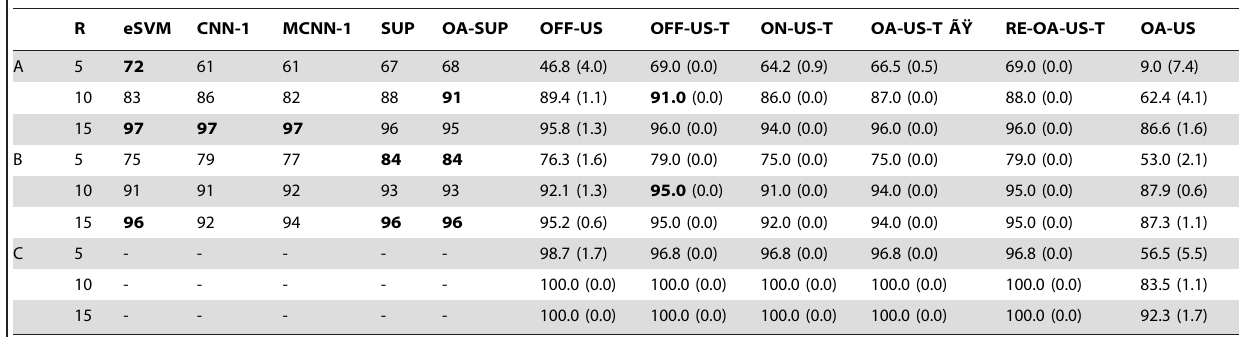
Table 1. BCI Competition Spelling